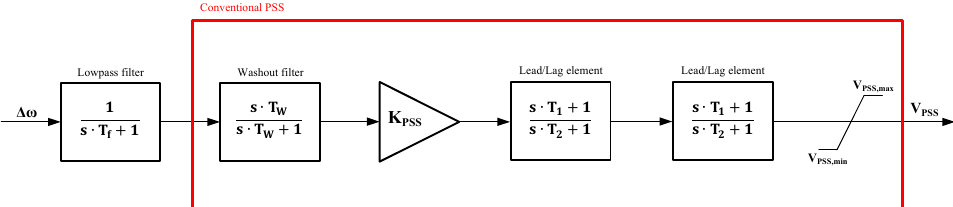
Figure 13. Conventional PSS (red frame) and the corresponding elements plus a lowpass filter to filter the input signal.